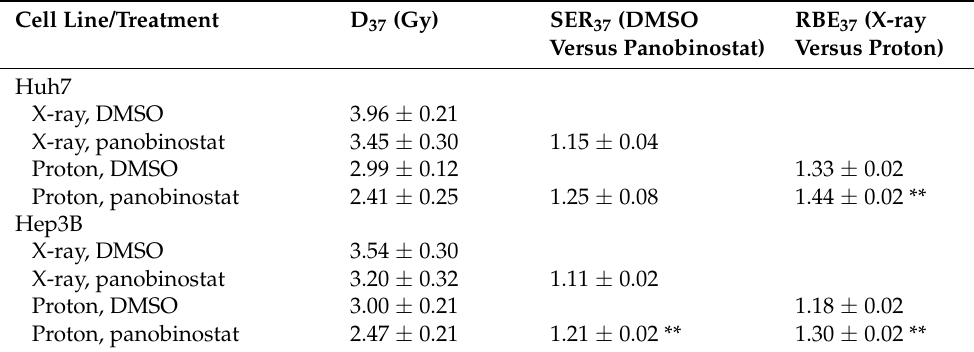
Table 1. Radiation response parameters of panobinostat-treated Huh7 and Hep3B